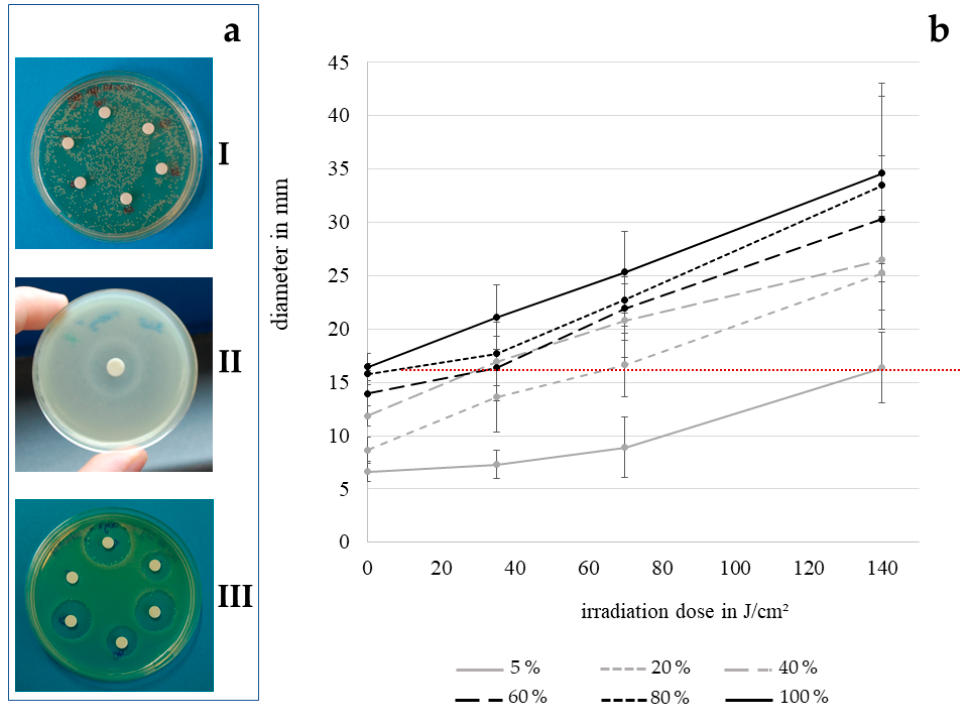
Figure 1. Demonstration of different agar plate appearances ( a ) with fragmentary lawn through excessive light dose of 280 J/cm 2 ( I ), indefinite inhibition zone with 130 mg/10 mL agar concentration and 100% ReNu Multiplus ( II ), optimal appearance with different concentrations of AOSept ( III ). Diameter of inhibition zones on P. fluorescens lawn achieved with different concentrations of hydrogen peroxide solution AOSept, dependent on the dose of 405 nm applied with 20 mW/cm 2 ( b ). Error bars indicate the deviation in the three experiments. The red dotted line indicates the size of inhibition zones generated with 100% AOSept without irradiation.